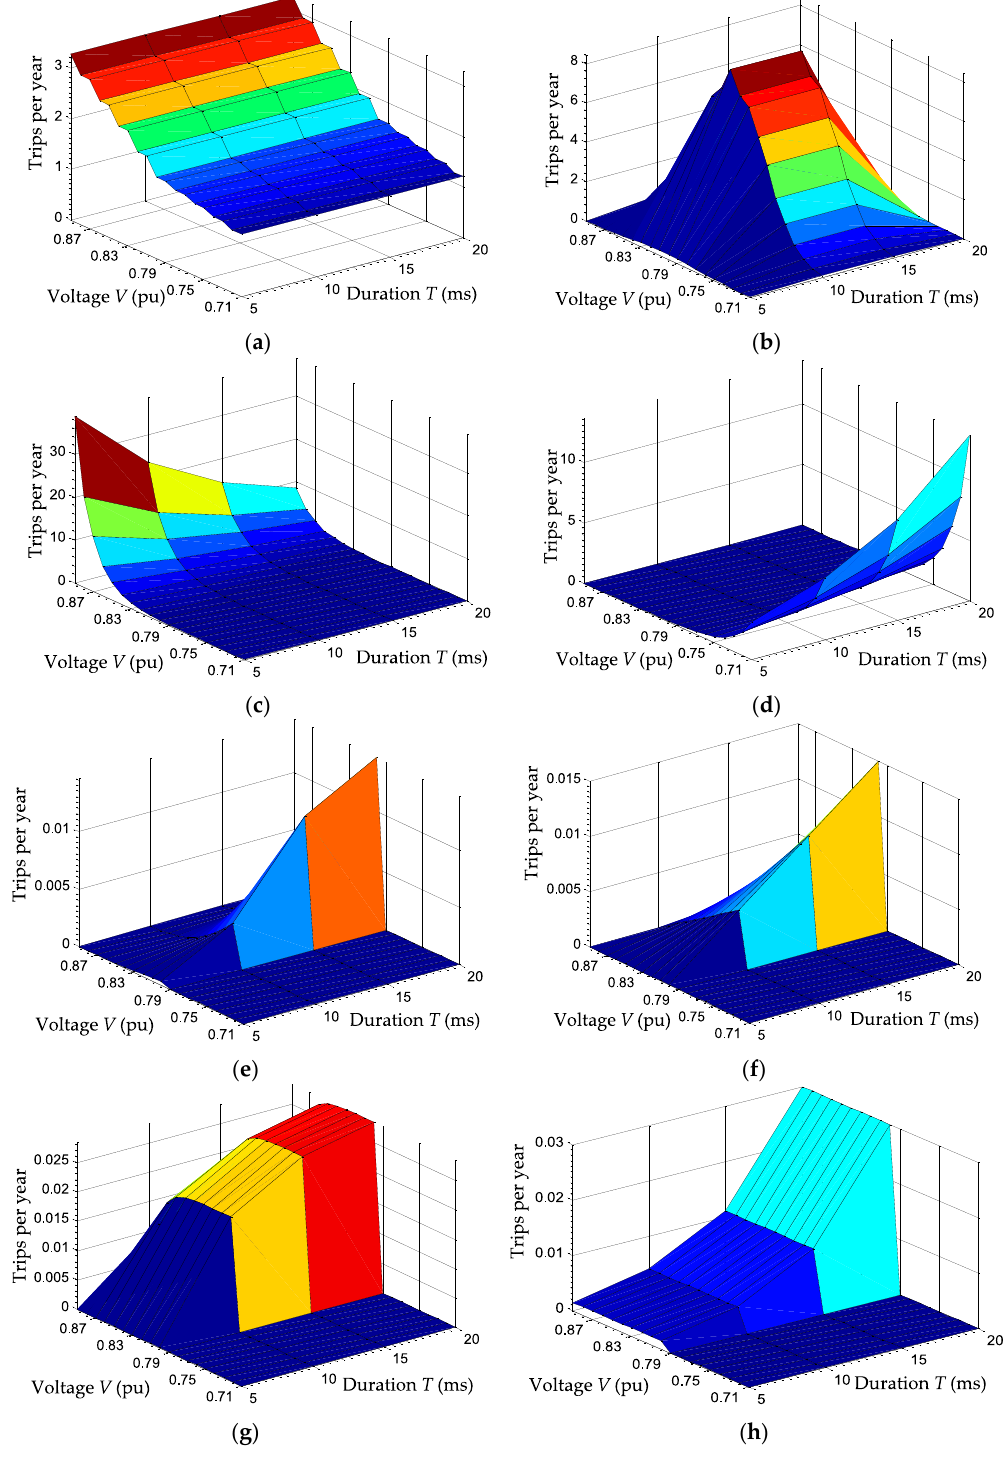
Figure 20. Number of expected trips per year of various voltage–tolerance characteristics for ASD: General probability method ( a ) uniform; ( b ) normal; ( c ) exponential; and ( d ) reverse exponential. Cumulative probability method ( e ) uniform; ( f ) normal; ( g ) exponential; and ( h ) reverse exponential.